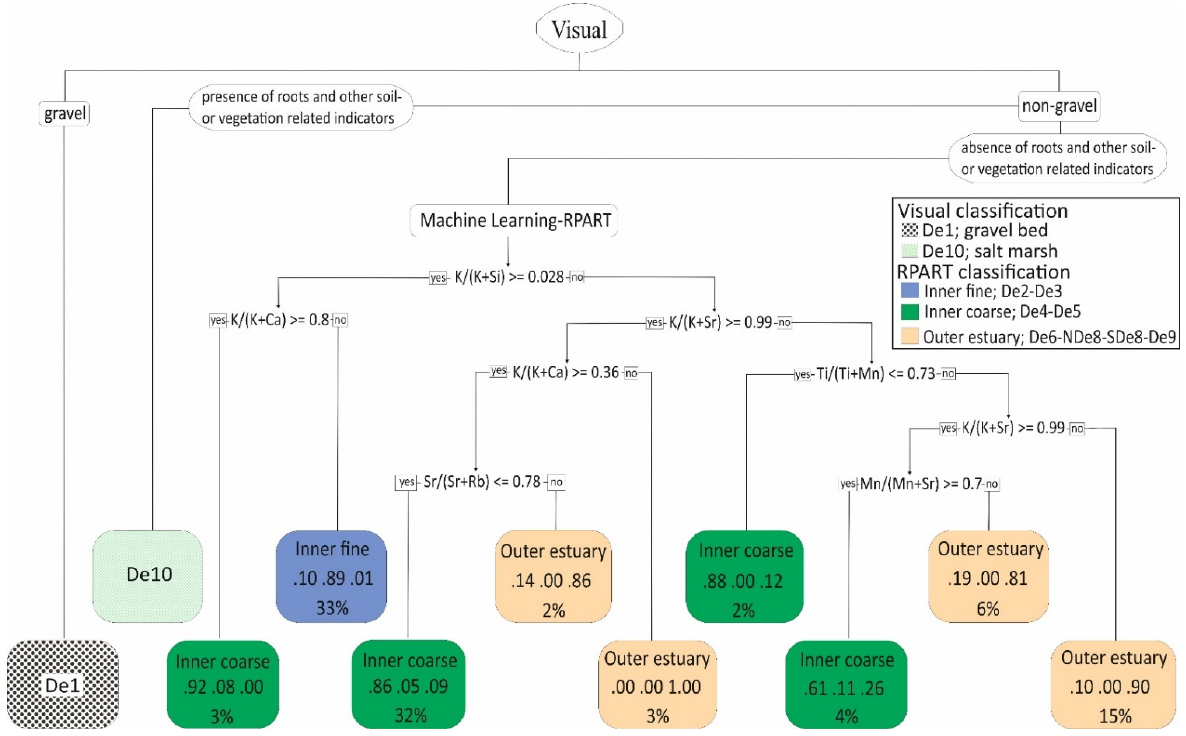
Figure 11. Classification tree based on partly merged data, developed using the same approach as Figure 10. This classification tree has a model accuracy of 87.0% (Figure 10) and shows how high model accuracy can be achieved with subsequent grouping of neighbouring or near neighbouring, sub-depositional environments.